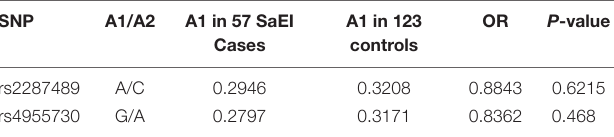
TABLE 4 | Association analysis of two top SNPs on chromosome 3 and infection-induced endocarditis in an independent case-control series of patients with S. aureus endocarditis: the Danish DANSAB